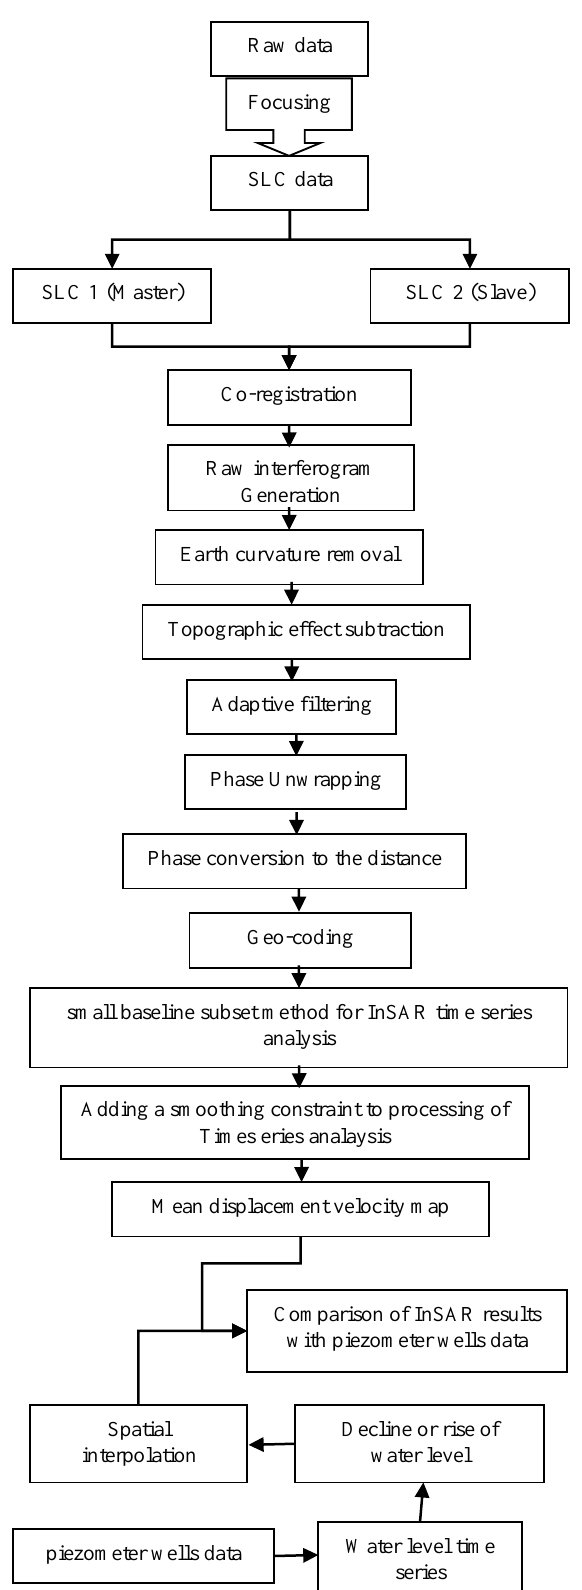
Figure 1. Basic structure of InSAR